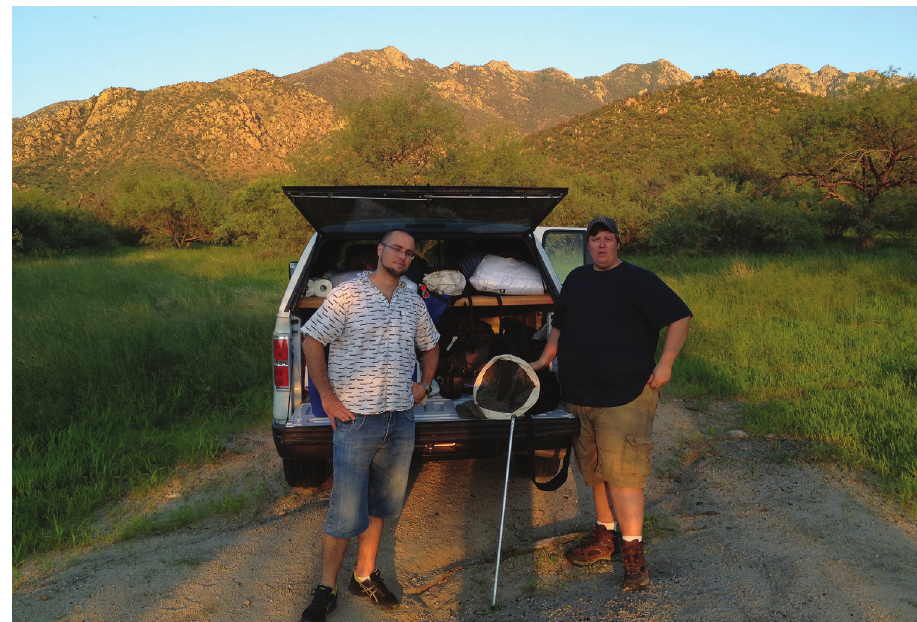
Figure 6. Post meeting collecting. Marcin Kamiński and Andrew Johnston near Madera Canyon.